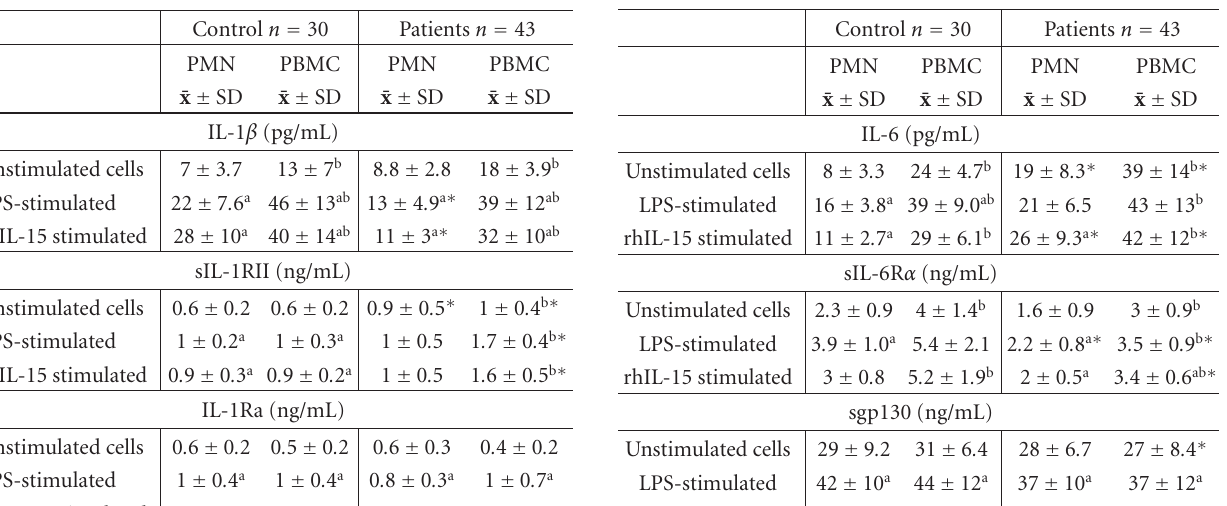
Table 2: IL-6, sIL-6R α , and sgp130 in the culture supernatants of PMN and PBMC from control and patients with Lyme disease.